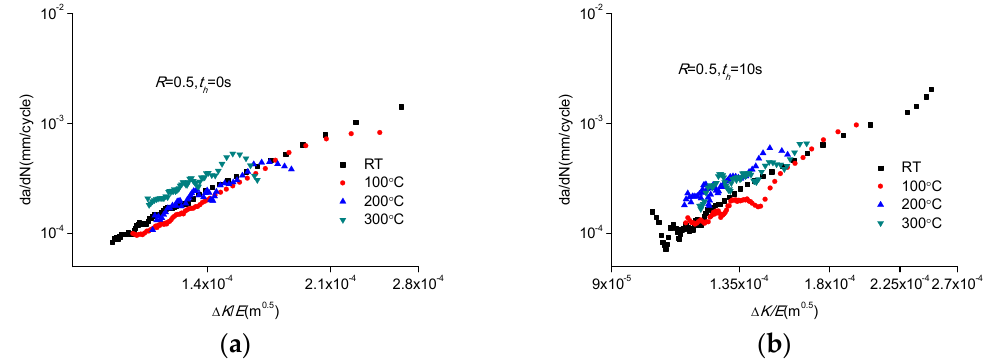
ratio: ( a ) pure fatigue; ( b ) dwell fatigue.